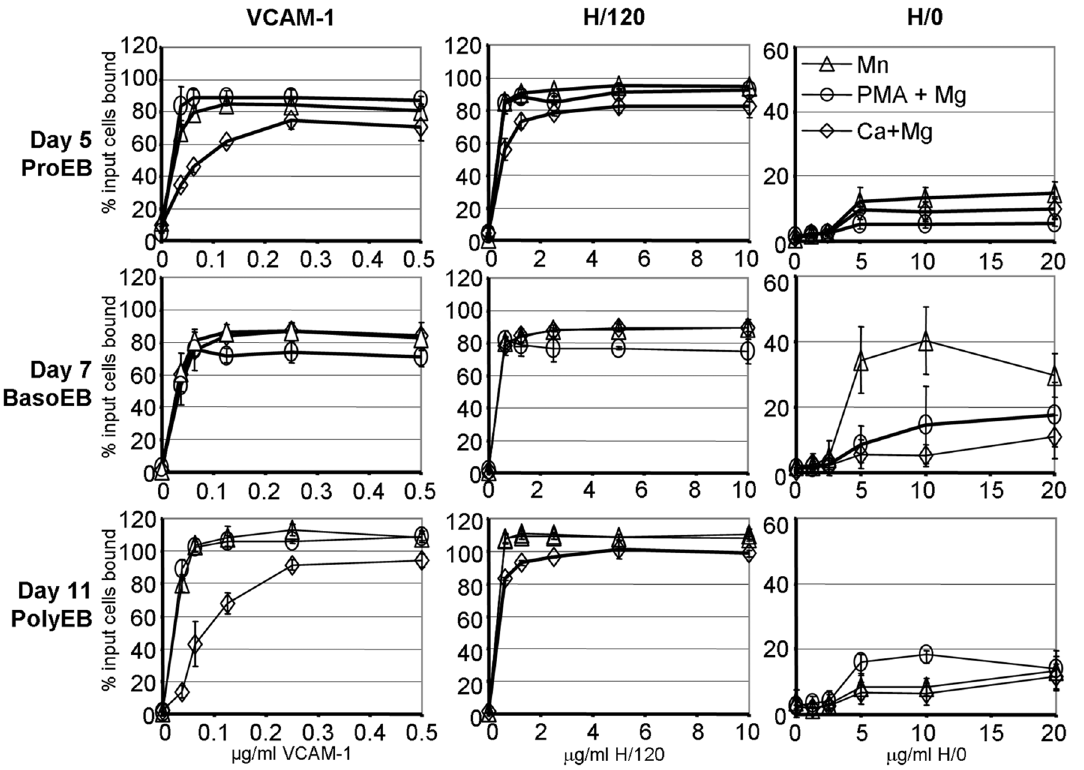
Figure 5. Effect of different activation conditions on erythroblast a 4 b 1 attachment to Vascular Cell Adhesion Molecule-1 and fibronectin fragments, H/120 and H/0. Erythroblasts were allowed to attach to dilutions of VCAM-1, H/120 and H/0 in the presence of different cations to activate a 4 b 1. e , 1 mM Ca 2 + plus 1 mM Mg 2 + ; D , 1 mM Mn 2 + ; # , 80 m M PMA plus 10 mM Mg 2 + . Day 5 cells (proerythroblasts, ProEB) were from one culture while days 7 (basophilic erythroblasts, BasoEB) and 11 (polychromatic erythrobalsts, PolyEB) cells were from a second culture